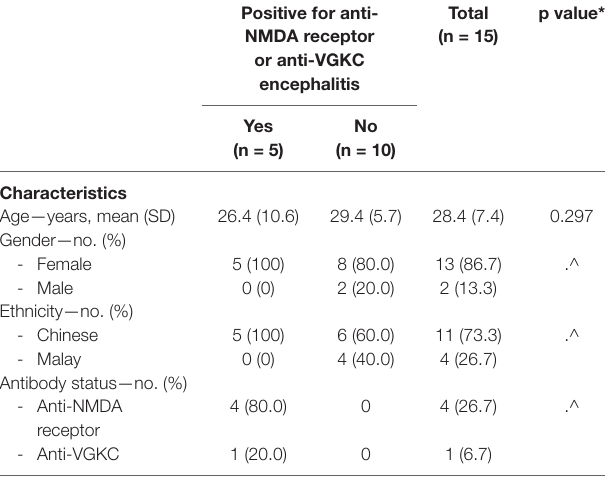
tABLE 1 | Participant characteristics. tABLE 2 | Prodromal